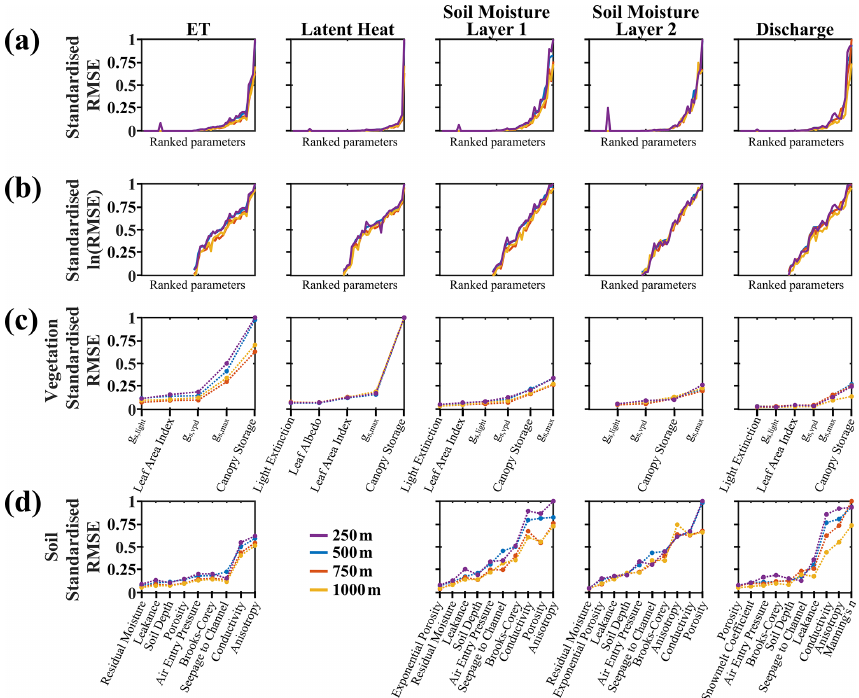
Figure 2. (a) Standardised root mean square error, (b) standardised root mean square error for the most sensitive vegetation parameters, and (c) standardised root mean square error for the most sensitive soil parameters for each output and spatial resolution. Vegetation parameters, g s , are the control of vegetation stomatal conductance, with maximum potential conductance ( g s,max ), light-controlling conductance ( g s,light ), and vapour-pressure-deficit-controlling conductance ( g s,vpd